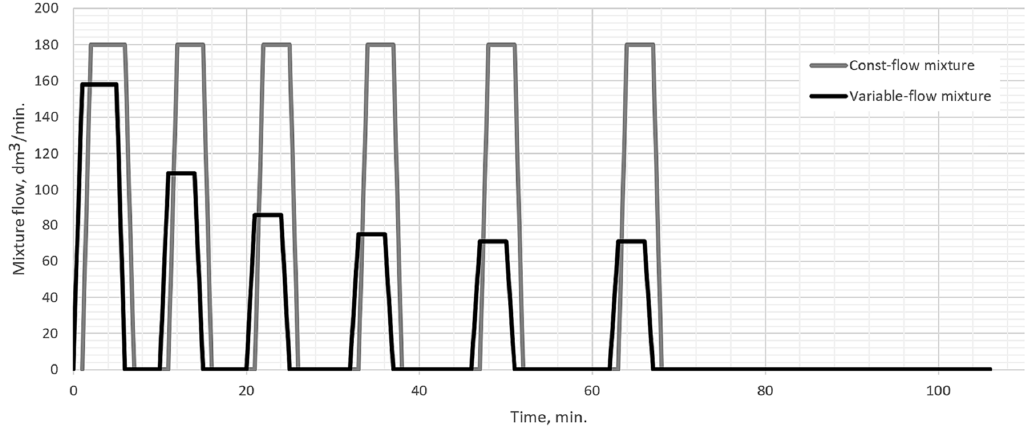
Figure 7. The amounts of carburizing gases used in the processes with constant and variable mixture flows.